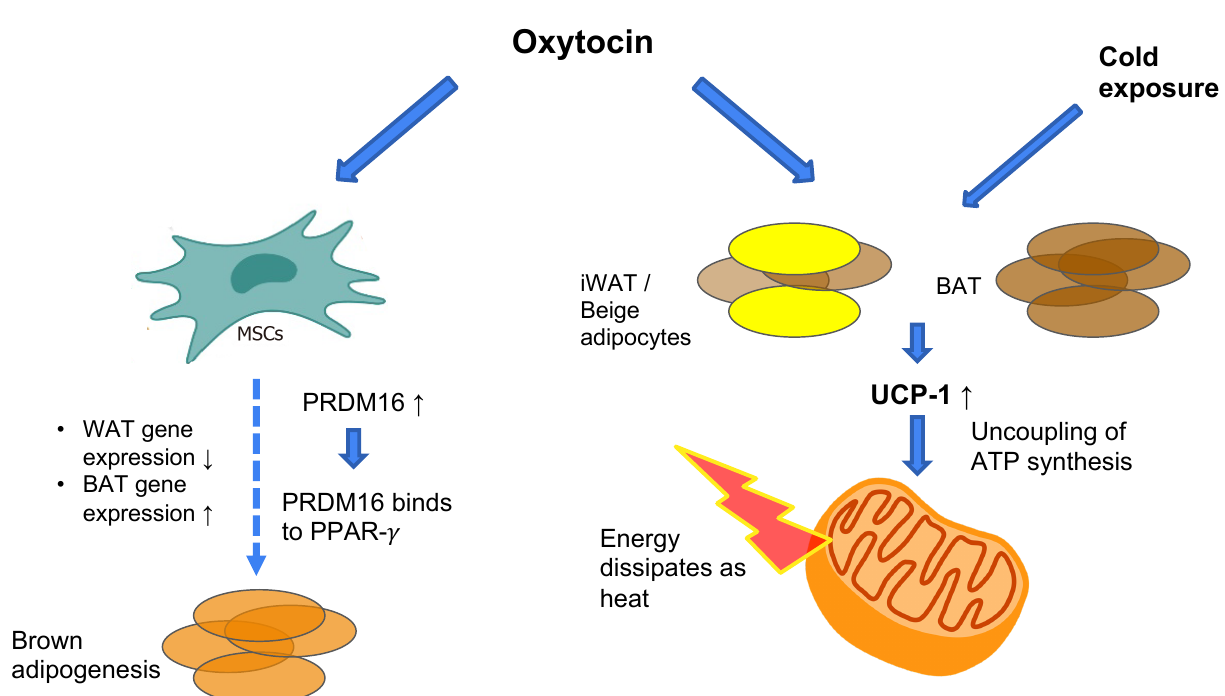
Figure 2. Proposed mechanism for the effects of oxytocin on thermogenesis and brown adipogenesis. Oxytocin may be an adipocyte browning inducer—in vitro treatment of pluripotent mesenchymal stem cells with oxytocin suppresses gene expression of white-adipose selective markers ( Nnmt and Retn ) while increasing expression of thermogenic genes (e.g., UCP-1 , Cidea , Ppargc1a , Dio2 , and Elovl3 ). Oxytocin also up-regulates PRDM16—a transcription factor that promotes brown adipose tissue (BAT) formation by binding to peroxisome-proliferator activated receptor-gamma coactivator 1 alpha (PPAR-gamma) and inducing brown adipogenesis from progenitor myoblasts. PRDM16 also suppressed white-adipocytes selective genes in BAT. Oxytocin also increases the expression of uncoupling protein-1 (UCP-1) in BAT and inguinal white adipose tissue (iWAT)/beige adipocytes. UCP-1 is a mitochondrial membranous protein that is uniquely expressed in brown adipocytes and has a pivotal role in BAT adaptive thermogenesis. UCP-1 promotes proton translocation through the inner membrane of brown adipocyte mitochondria, thus diverting respiration from ATP synthesis to energy dissipation in the form of heat. Specific cues (e.g., cold exposure) also increase UCP-1 expression and thermogenesis. In vivo, oxytocin enhances the expression of UCP-1 in both mice and rat BAT and iWAT, thus promoting